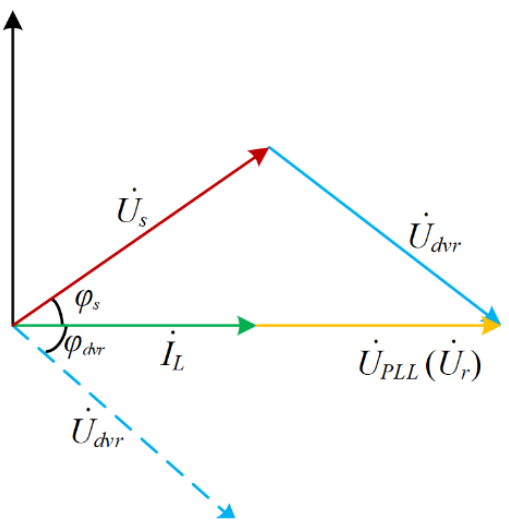
Figure 3. Compensation phasor diagram of pre-sag.